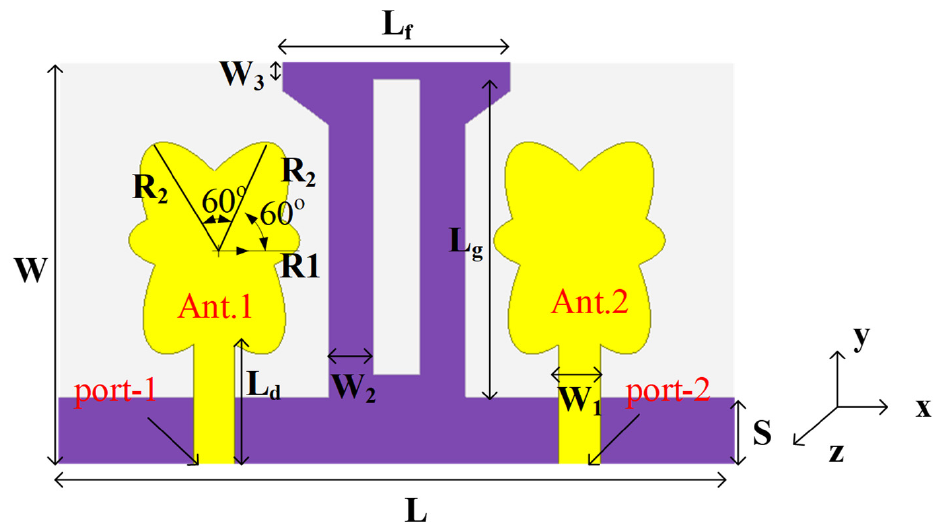
Figure 1. The proposed dual-port, flower-shaped UWB-MIMO antenna system structure.